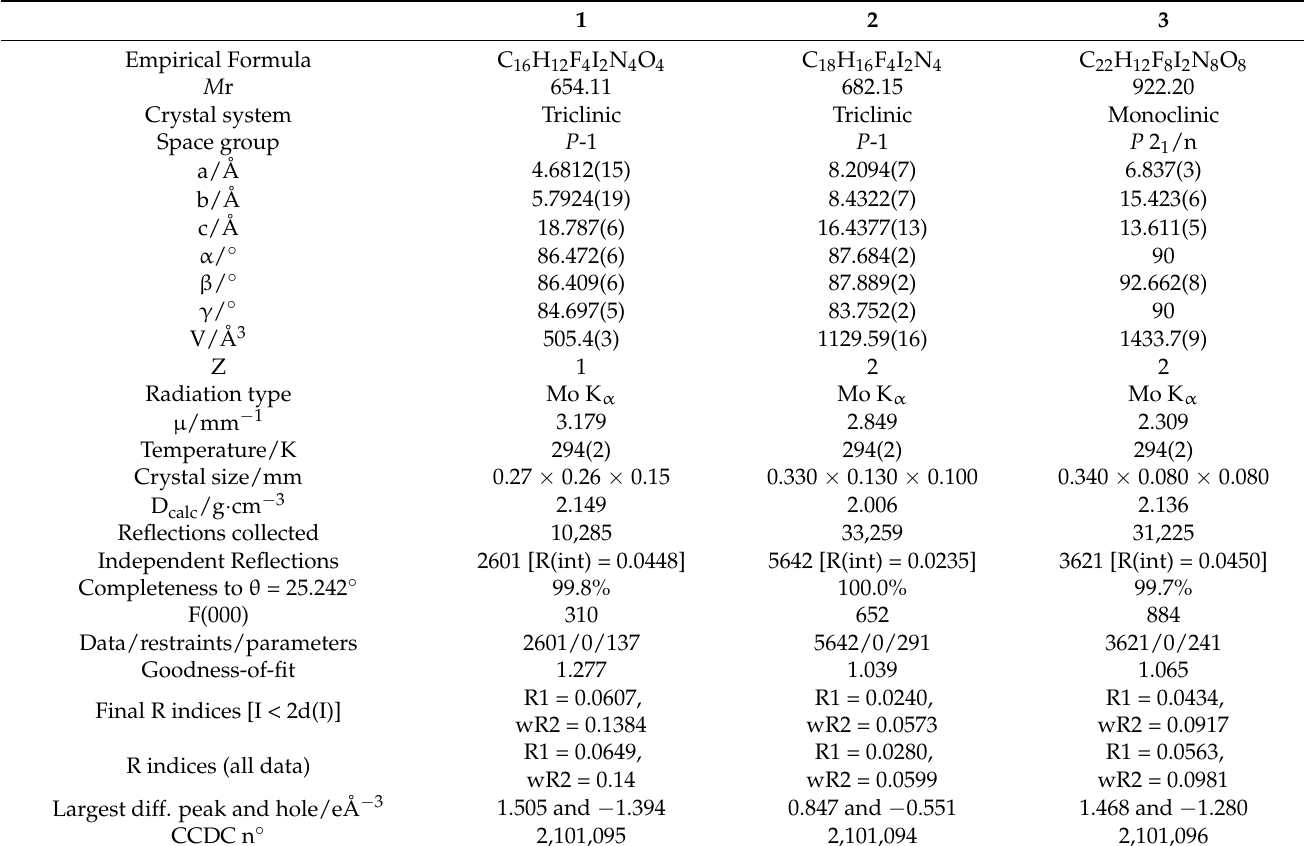
Table 2. Crystallographic data and refinement for cocrystals 1 – 3